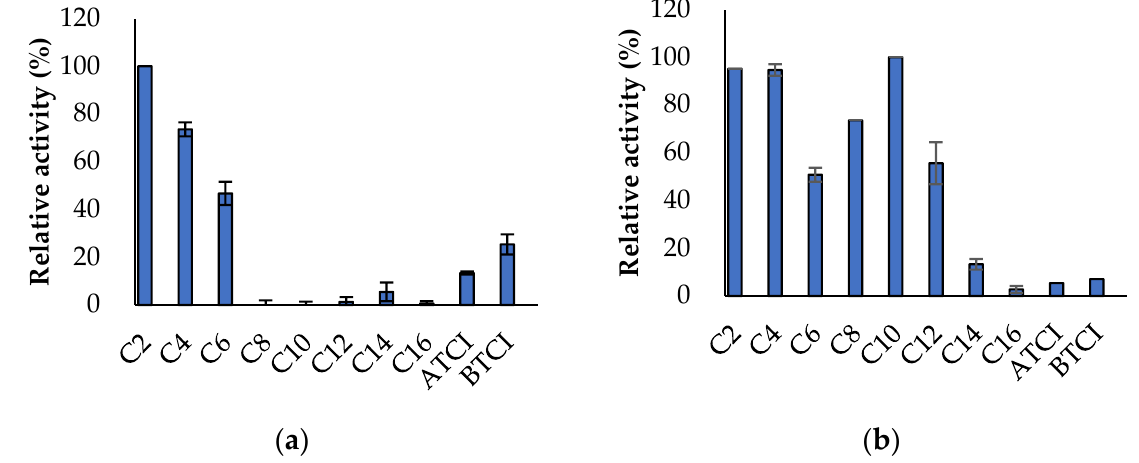
Figure 7. Substrate specificities of Est2L ( a ) and Est4L ( b ). Enzyme activities with C2 to C16 were measured using 1 mM